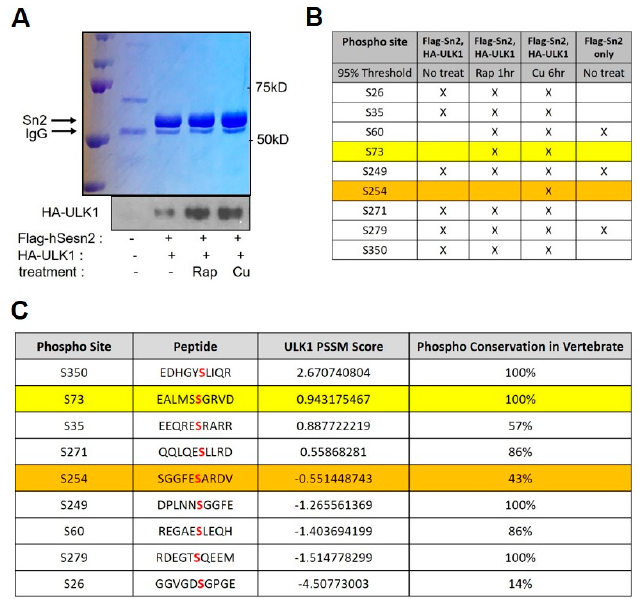
Figure 4. Ser-73 and Ser-254 are Cu-stress-specific phosphorylation sites of human Sestrin2 by ULK1 kinase. ( A ) Coomassie staining of FLAG-tagged human Sestrin2 (hSestrin2) and immunoblotting of HA-tagged ULK1 kinase after being treated with 100 nM rapamycin (Rap) for 1 h or 500 µM CuSO 4 for 6 h in HEK293 cells. No treatment was used as a control. ( B ) Mass spectrometry analysis of phosphorylated hSestrin2 by ULK1 kinase from coomassie brilliant blue staining samples in ( A ). ( C ) In hSestrin2, ULK1 motif-matching scores and conservation were analyzed by bioinformatics analysis using the motif prediction program. Red letters in Peptide column indicate the specific residue of phosphorylation site (Phospho Site). A detailed algorithm can be found in the Methods Section.